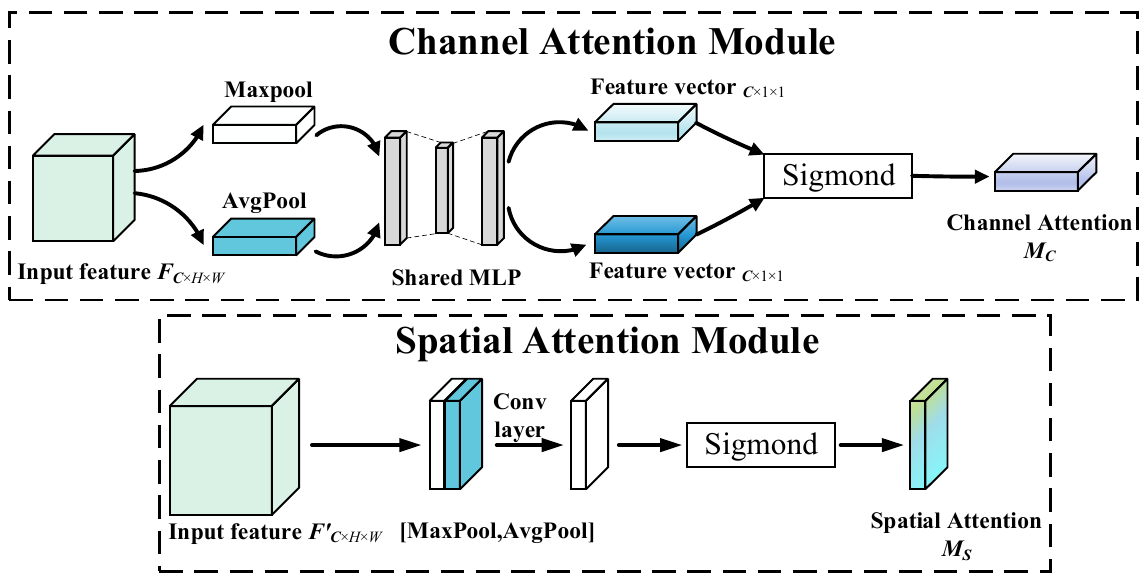
Figure 4. Schematic diagram of channel attention module and spatial attention module.